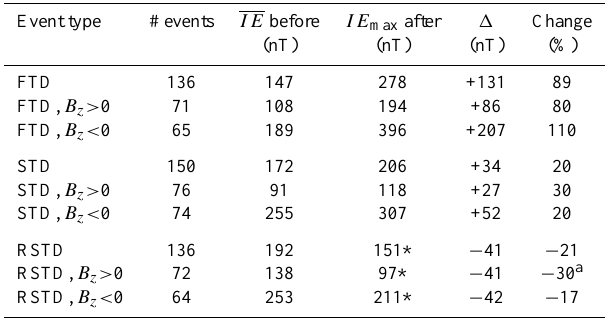
Table 1. IE index response to pressure changes during different event